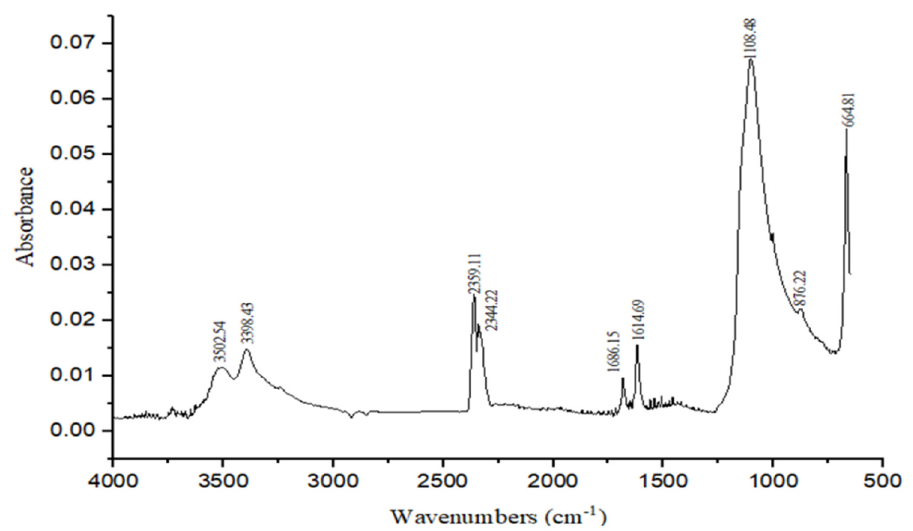
Figure 2. FTIR spectrum of WFGD gypsum.